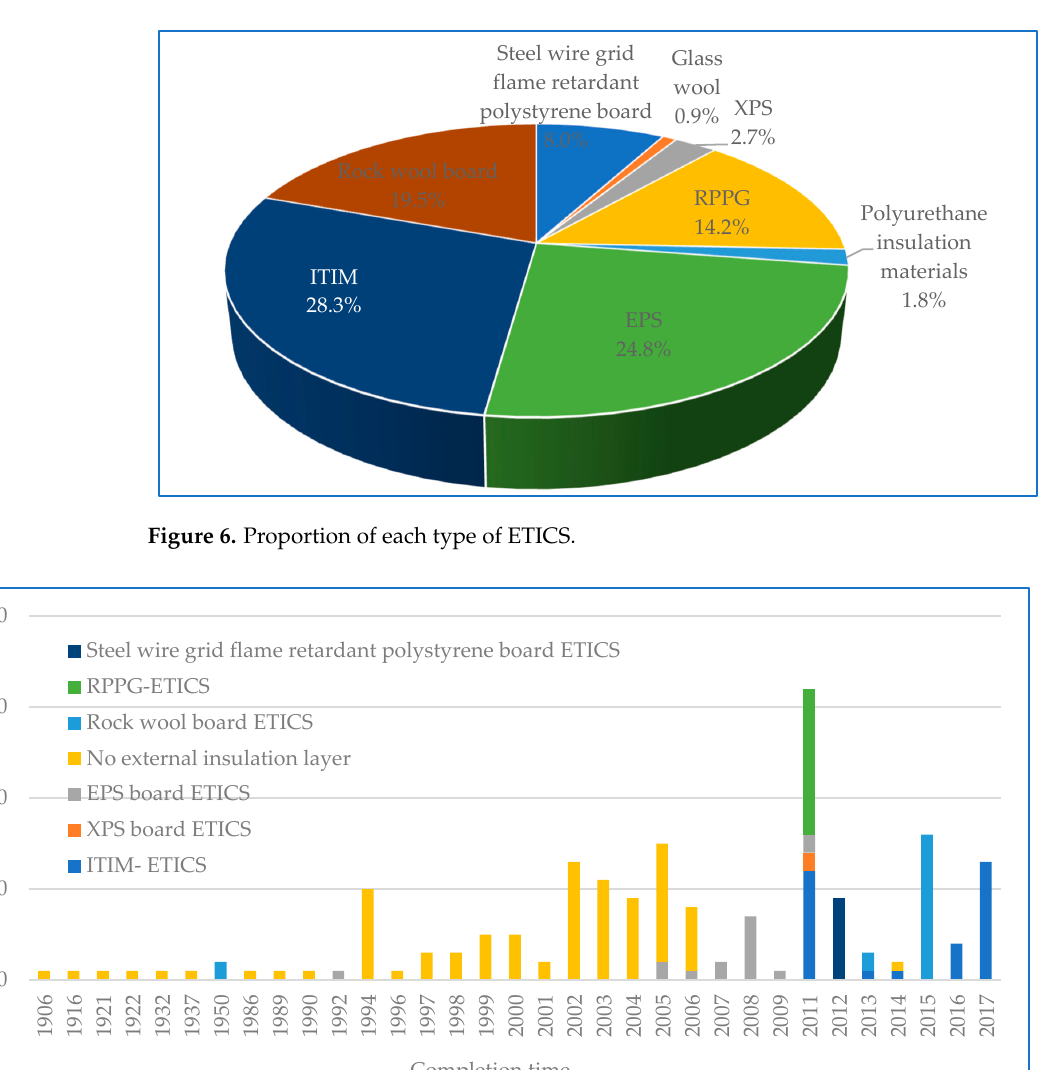
Figure 7. Type of ETICS at different completion times.